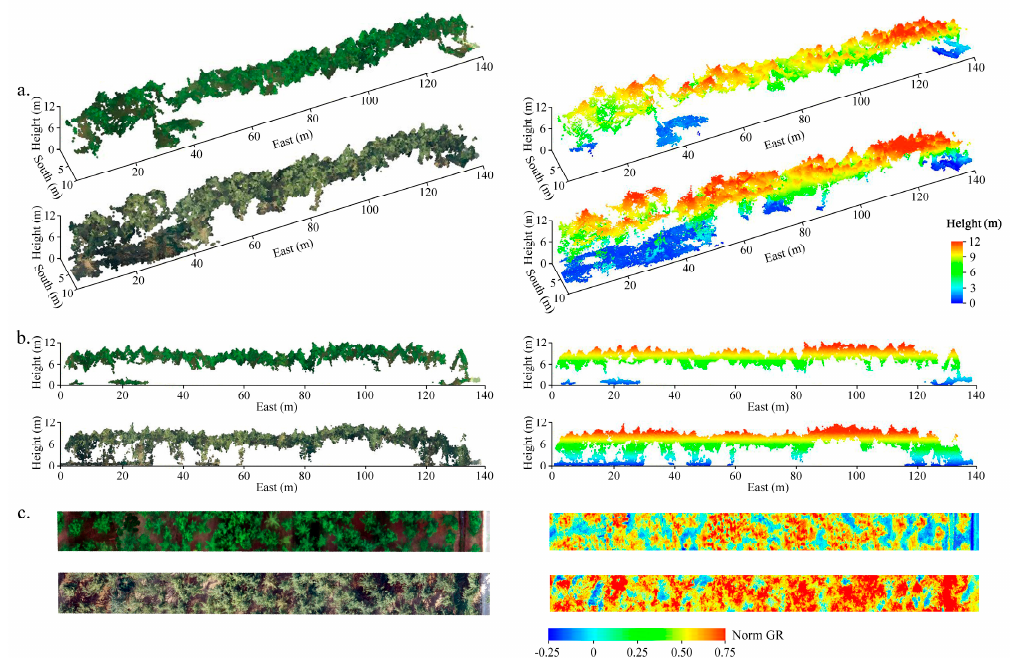
Figure 3. ( a ) Three dimension display of digital aerial photogrammetry (DAP) point clouds derived from UAS multispectral and RGB (Red-Green-Blue) imageries. ( b ) The profile of digital aerial photogrammetry (DAP) point clouds derived from UAS multispectral and RGB imageries. ( c ) The maps of normalized green-red ratio calculated from ortho-multispectral and RGB imageries.